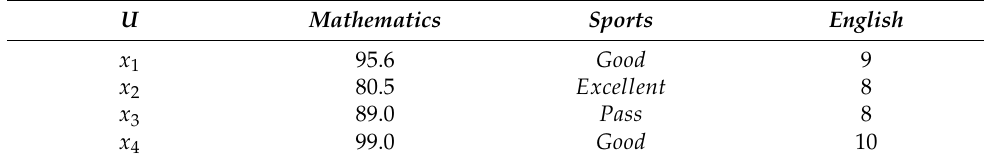
Table 1. The table of student achievement.